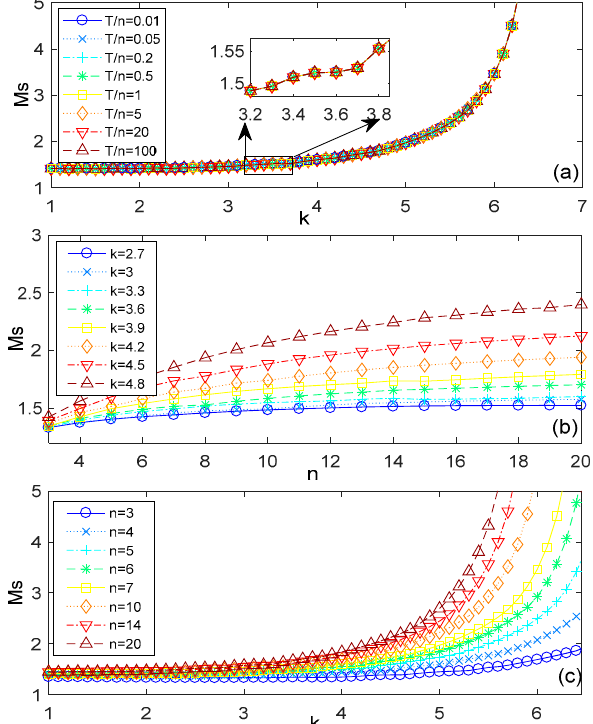
Figure 3. Influence of n , T , and k on M s . ( a ) M s changes with k under different T / n , when n = 7, K = 1; ( b ) M s changes with n under different k , when T / n = 7, K = 1; ( c ) M s changes with k under different n , when T / n = 1/15, K = 1.